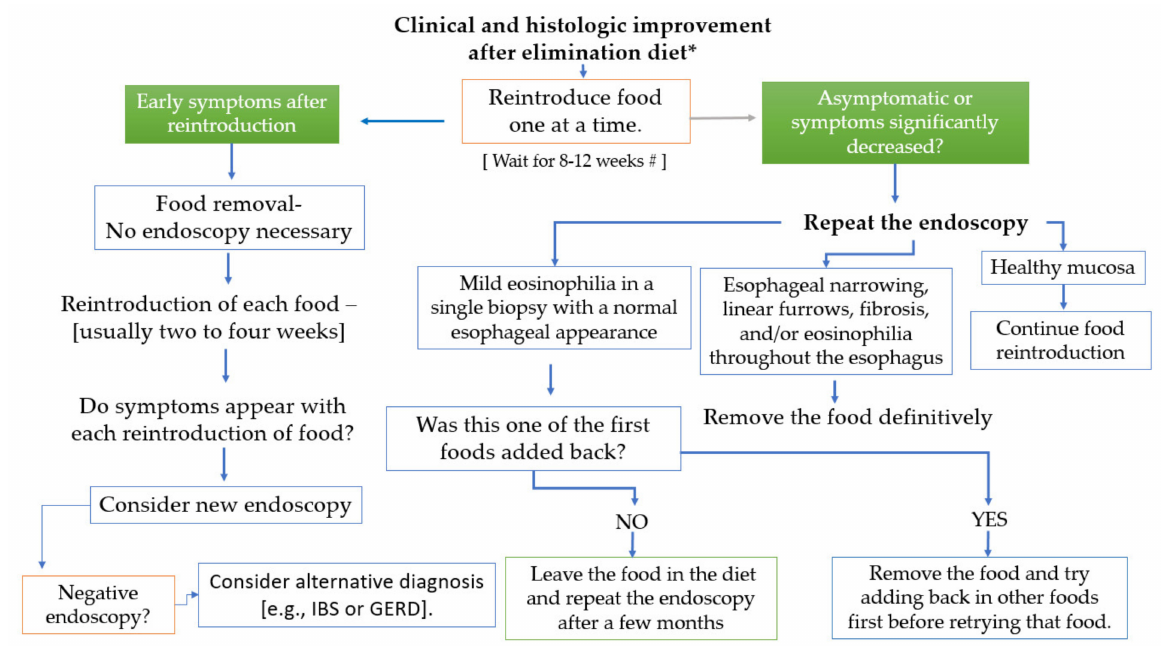
Figure 4. Food reintroduction protocol after verifying symptomatic and histological remission eight weeks after initiating a dietary intervention. * British Society of Gastroenterology (BSG) and British Society of Paediatric Gastroenterology, Hepatology and Nutrition (BSPGHAN) recommend starting with the 2-food elimination diet Ref. [94]. However, the algorithm also applies to 4- or 6-FEDs. [#] two to four weeks is a reasonable alternative clinical approach. [#] two to four weeks is a reasonable alternative clinical approach. IBS: irritable bowel syndrome; GERD: gastroesophageal reflux